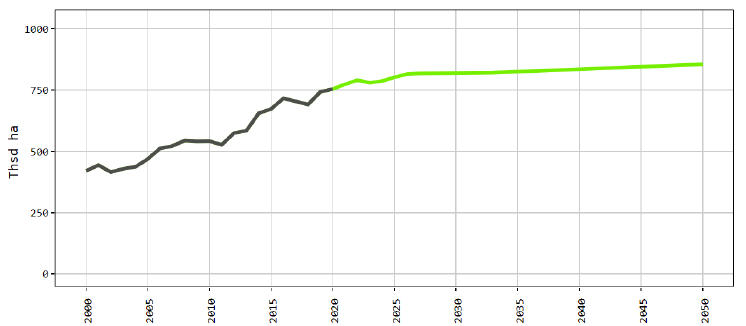
Figure 7. Cereal area in 2000–2020, with a 2021–2050 projection for Latvia, in thousands of hectares [62].